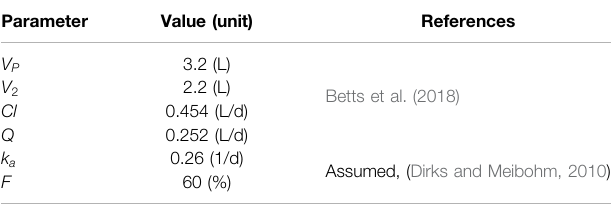
TABLE 3 | Antibody PK parameters for osteopontin feasibility analysis. Parameter